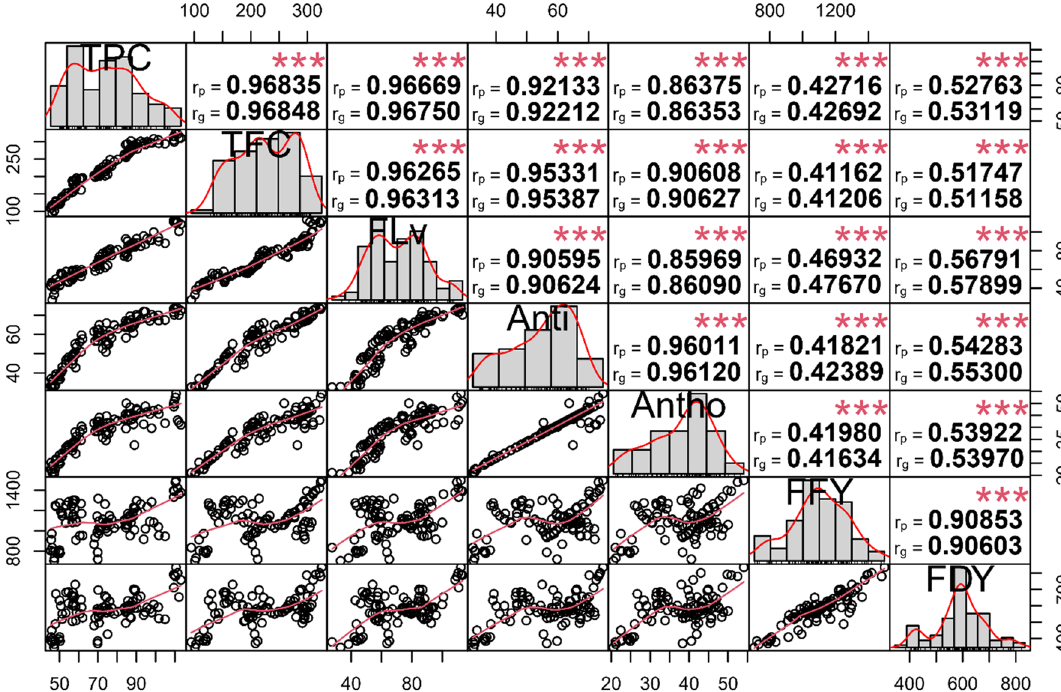
Figure 3. Phenotypic (r p ) and genotypic (r g ) correlation coefficients for traits in 100 Poa pratensis accessions evaluated in non-stress conditions.